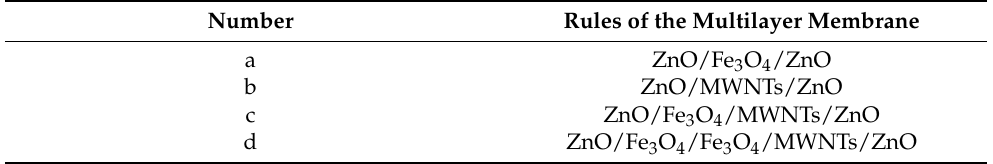
Table 2. The combination of the multilayer